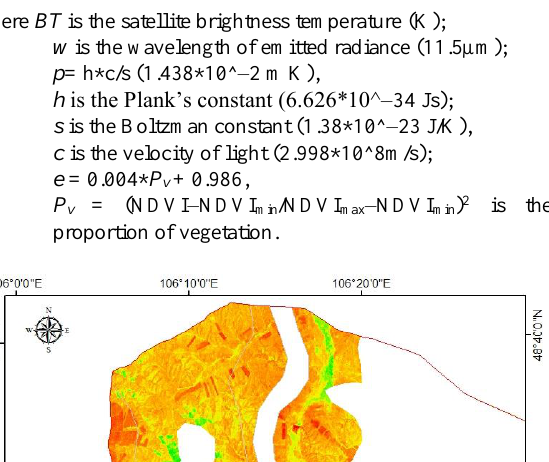
Figure 6. LST map from Landsat +ETM7